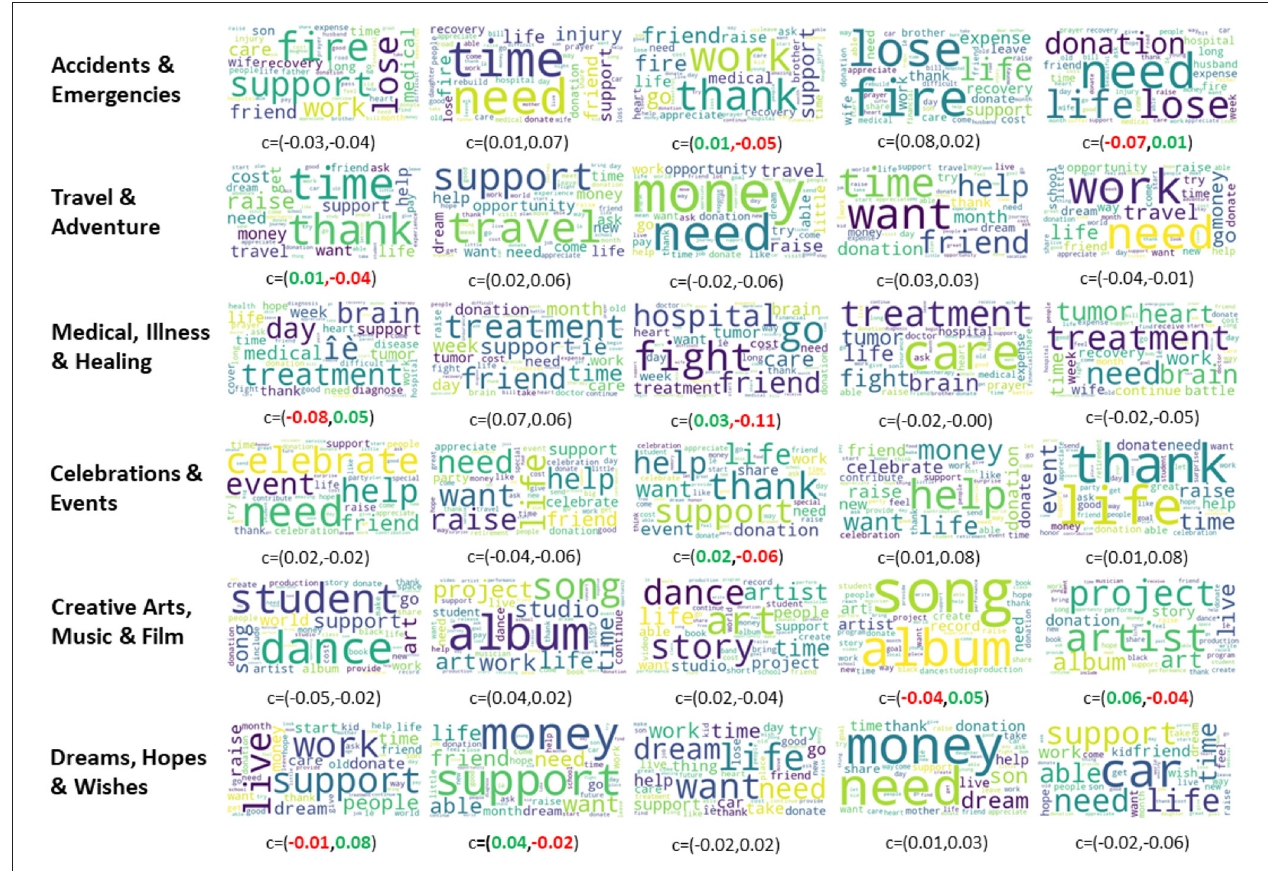
FIGURE 2 | Topics under different categories. The first value represents the correlation coefficient before the COVID-19 outbreak, while the second value represents the coefficient after the outbreak. A green value indicates that the topic has a positive impact on success, while a red value indicates that the topic has a negative impact on success. Note those topics with changes in the polarity of the impact before and after the COVID-19 pandemic.